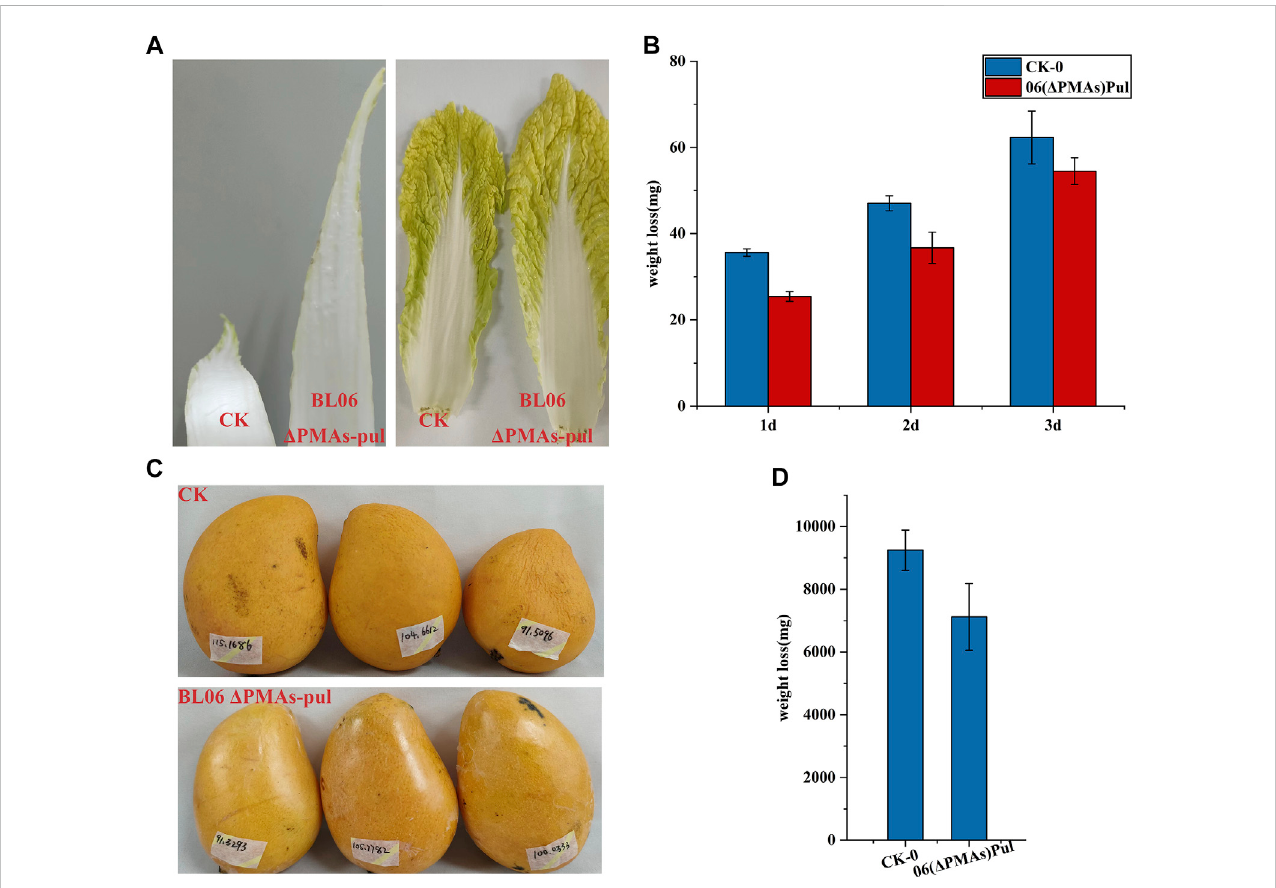
FIGURE 6 FoodcoatingapplicationofthemoderateMwpullulan fi lms. (A) Comparisonofapparentstatesofcelerycabbagessmearedwithpullulan fi lmsornot; (B) Comparisonofapparentstatesofmangossmearedwithpullulan fi lmsornot; (C) Comparisonofweightlossofcelerycabbagessmearedwithpullulan fi lmsor not; (D) Comparison of weight loss of mangos smeared with pullulan fi lms or not; All values are expressed as the means ± SDs ( n =